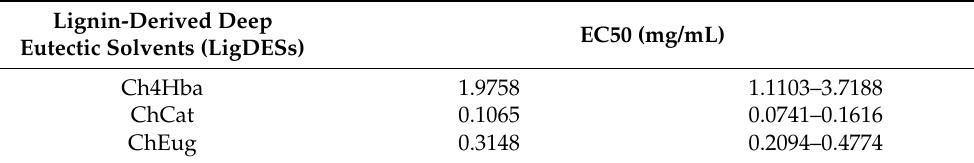
Table 2. Antioxidant activity of as prepared LigDES systems and half maximal effective concentration or amount of compound/extract necessary to decrease the initial concentration of DPPH to 50% at equilibrium (EC50) determination by means of DPPH assay.